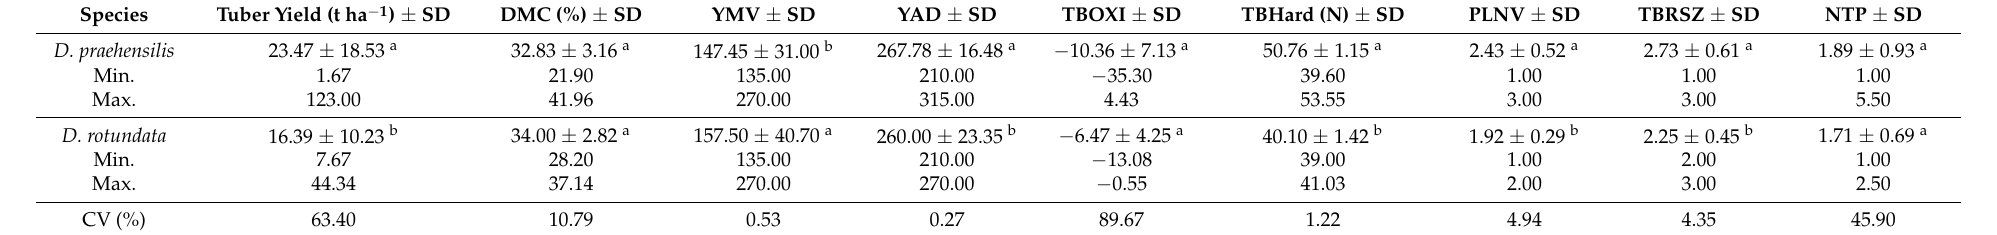
Table 2. Mean variations in key agronomic and tuber quality traits of D. praehensilis and D. rotundata